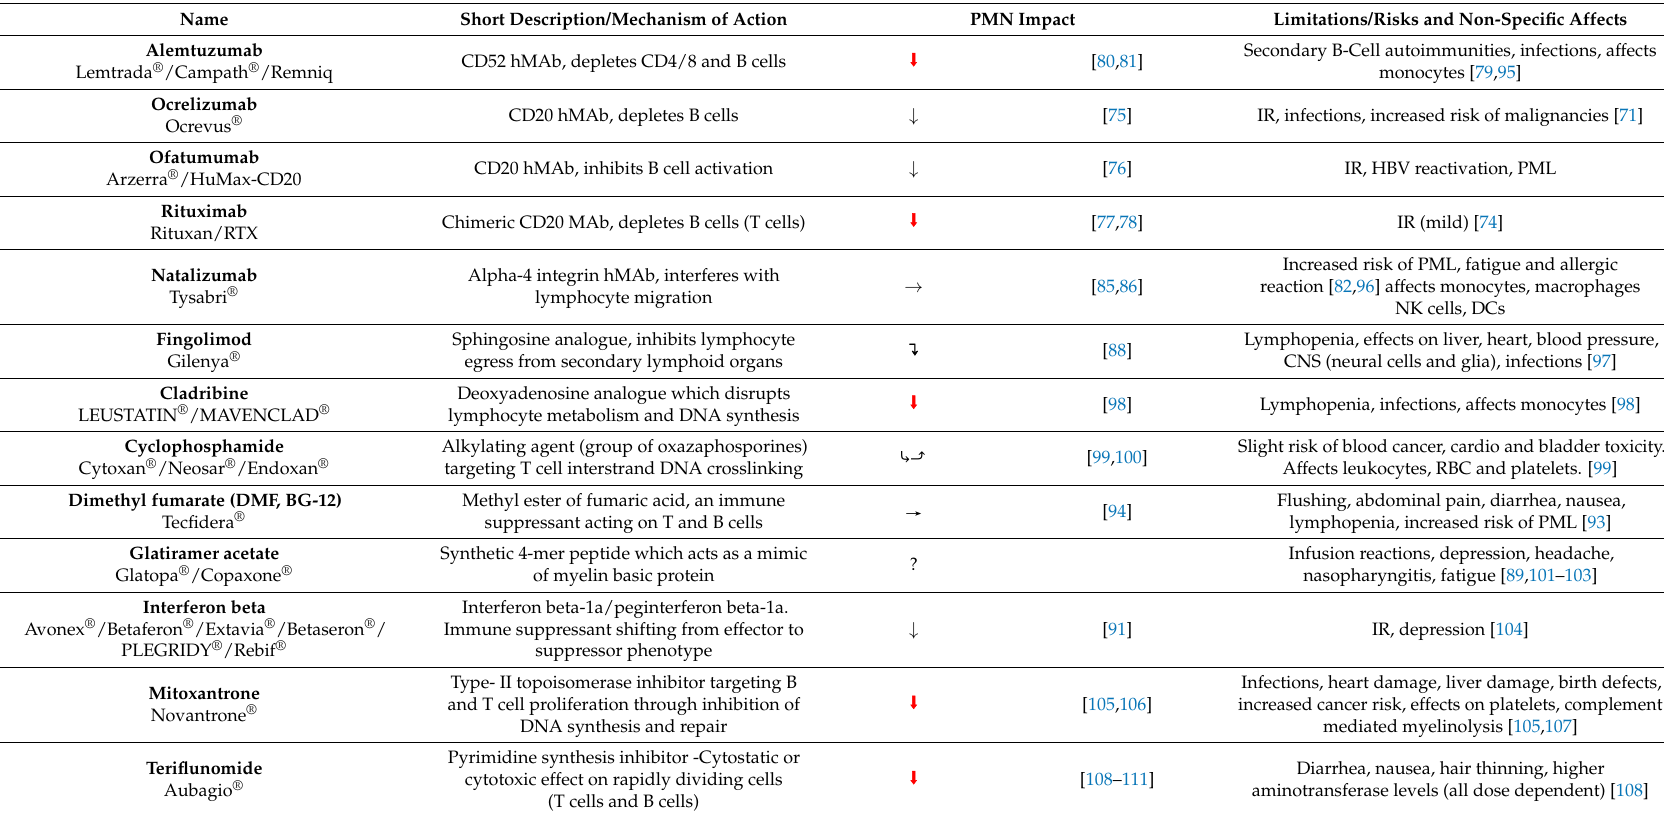
Table 1. Non-curative disease modifying therapies licensed for MS and their impact on neutrophils